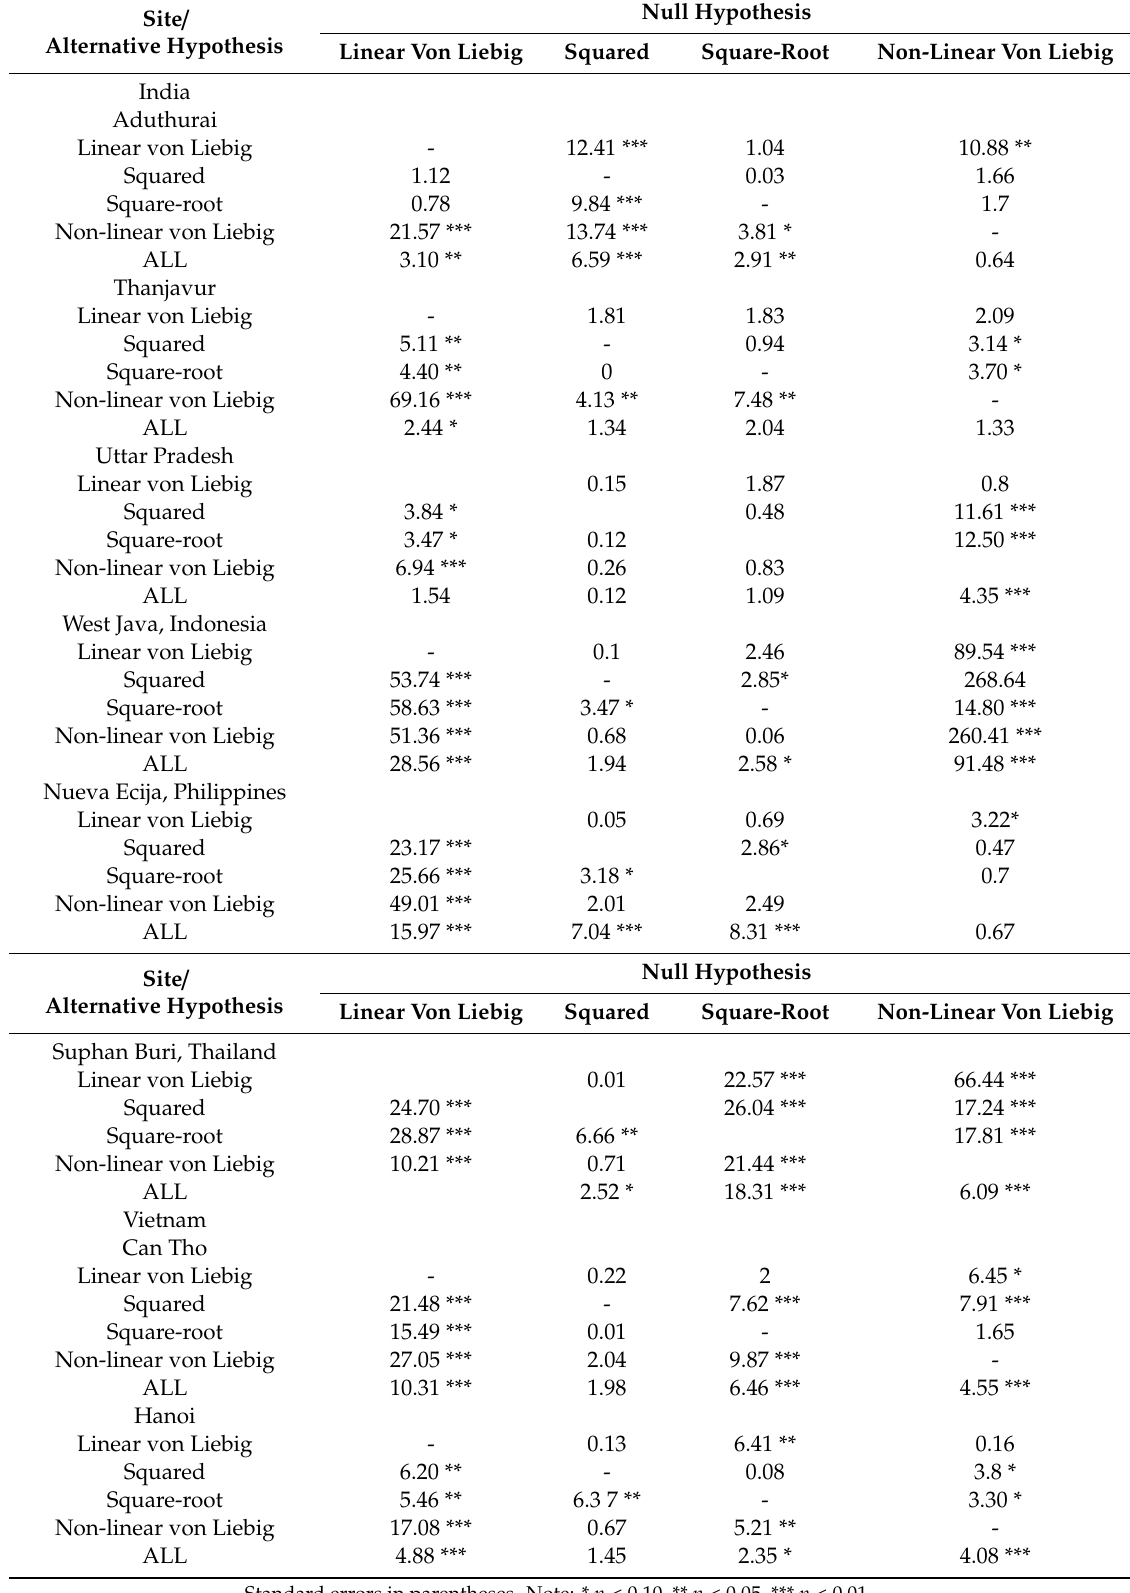
Table 11. Non-nested hypothesis test